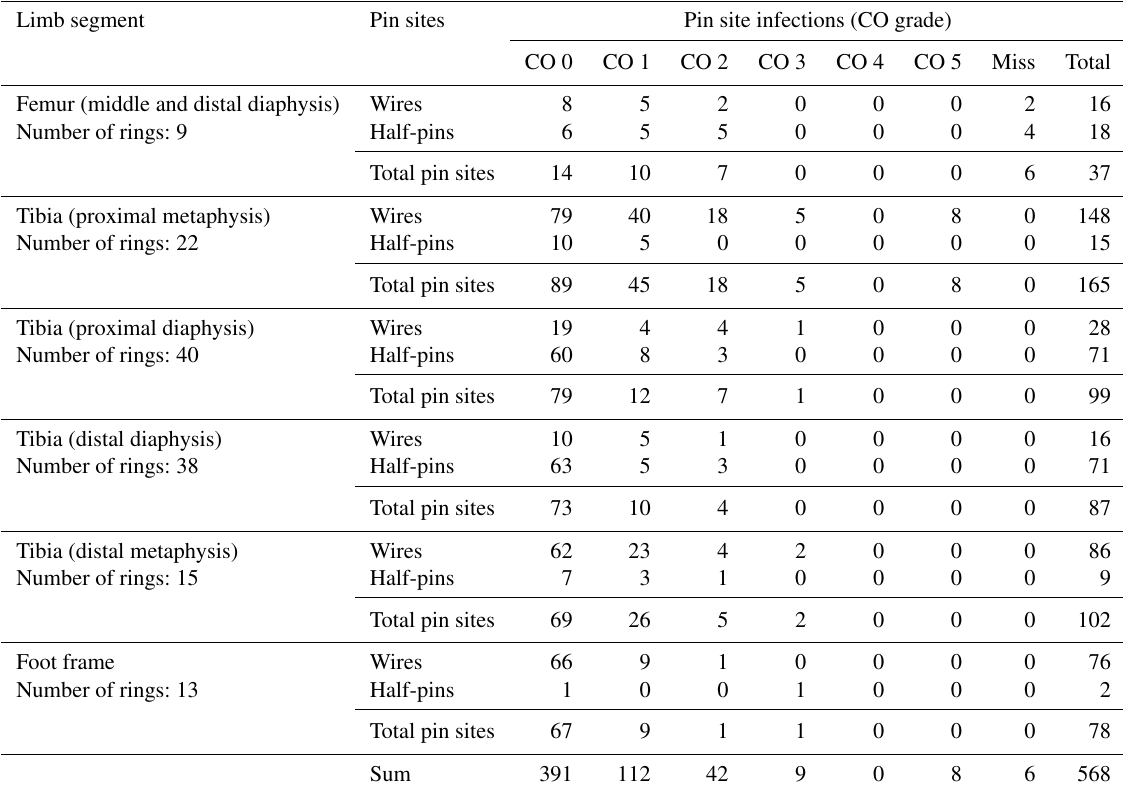
Table 2. Overview of anatomical pin site locations, quantity, and CO grading. Miss: missing information.